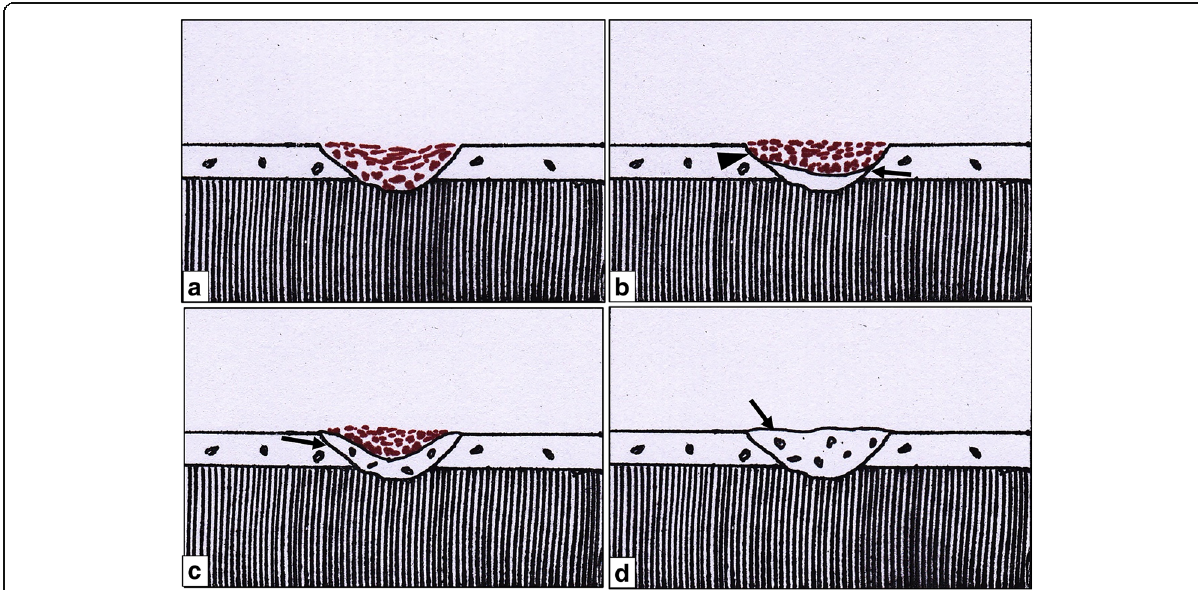
Fig. 4 Schematic presentation of the level of repair cementum. Craters showing a no repair, b partial repair with only a part of the surface of the resorption cavity covered with reparative cementum ( arrow ) and the remaining surface exposed ( arrowhead ), c functional repair with the total surface of the resorption cavity covered with reparative cementum ( arrow ) without re-establishment of the original root contour, and d anatomic repair with the total surface of the resorption cavity covered with reparative cementum ( arrow ) to such an extent that the original root contour is re-established